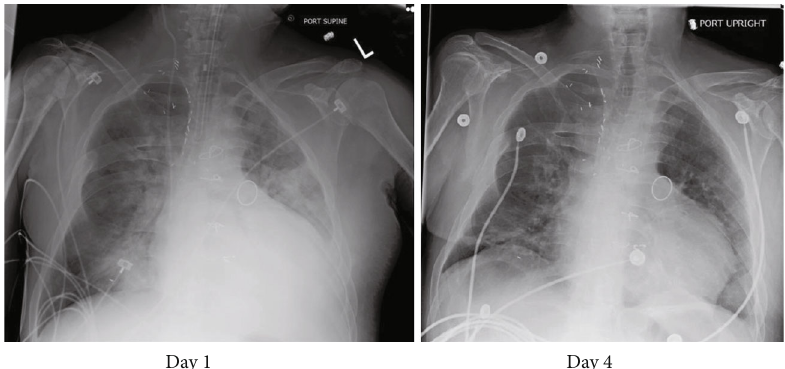
Figure 3: Initial plain chest fi lm demonstrating acute pulmonary edema and repeat study at four days of hospitalization with improvement in volume overload. Congenital rib deformity and pulmonic valve ring are visible in both images.